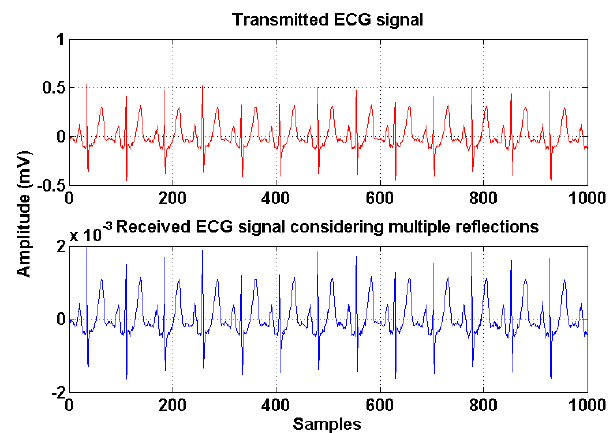
Figure 5. Transmitted and received electrocardiography (ECG) signal in non-directed optical links.